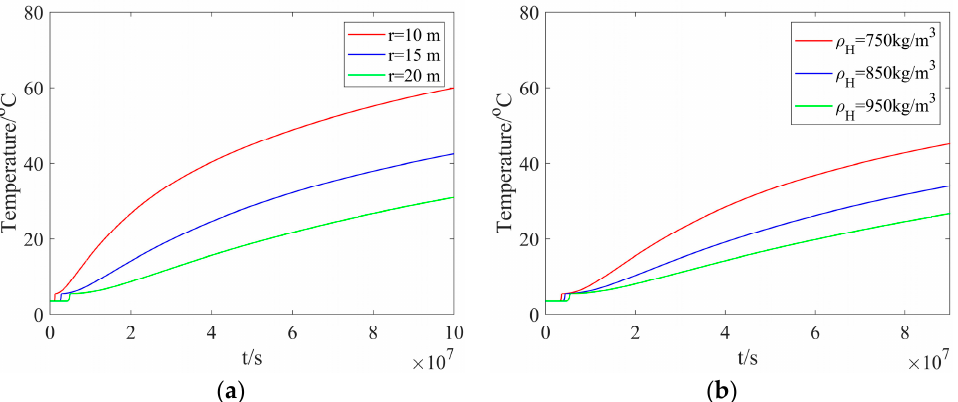
Figure 4. The reservoir temperature: ( a ) different radial distances and a fixed hydrate density; ( b ) different hydrate densities and a fixed radial distance.